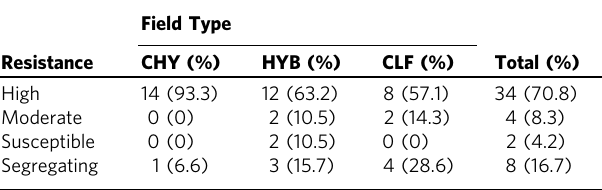
Resistance levelsof contemporary weedy rice samples. Samples are binned into four categories: high (0 – 32% average tissue damage), moderate (33 – 67% average tissue damage), susceptible (68 – 100% average tissue damage), and segregating. CHY, HYB, and CLF represent fi eld cropping histories representing fi elds that historically grew Clear fi eld ™ hybrid, non-Clear fi eld ™ hybrid, and Clear fi eld ™ inbred cultivars,